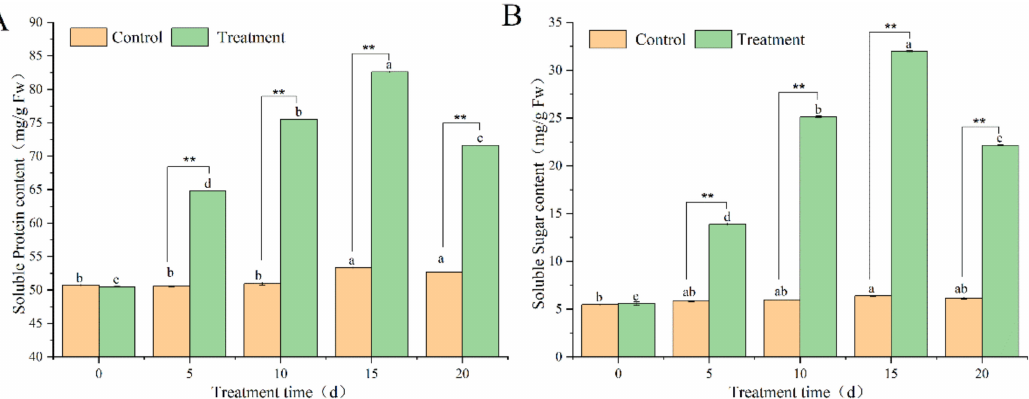
Figure 5. Effects of BY6 on soluble protein ( A ) and sugar ( B ) content in Pdpap poplar leaves. The experiment was carried out in four biological replicates; ** indicate significant differences between the groups at the same time point (ANOVA, ** < 0.01), and the different lowercase letters indicate significant differences for the same treatment group at different times (ANOVA, p <